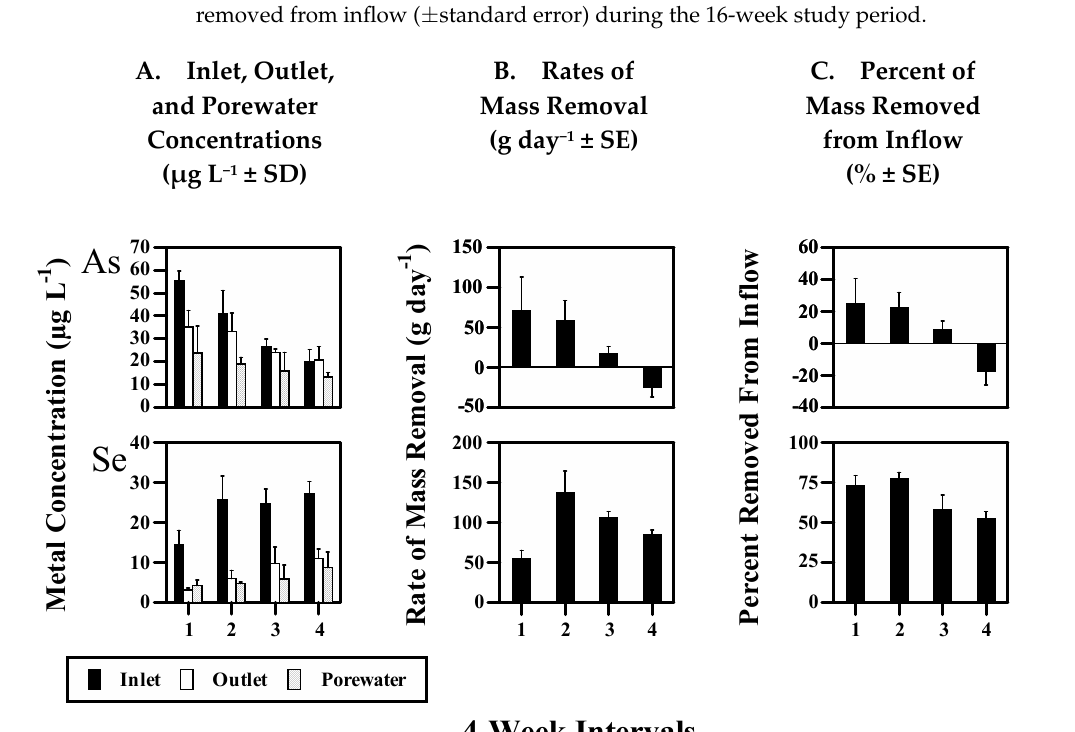
Figure 4. Sink elements: As and Se. Periodic (4 week) mean values for: ( A ) Inlet, Outlet, and Porewater concentrations (µg L − 1 ± standard deviation; n = 4 for inlet and outlet; n = 15–30 for porewater); ( B ) rates of mass removal (g day − 1 ± standard error); and ( C ) percent of mass removed from inflow (± standard error) during the 16 week study period. Porewater concentrations were compared to inlet and outlet concentrations with sim- ilar results. Sink element overall mean porewater concentrations were significantly less than inlet concentrations (Table 2), and were generally less than inlet and outlet concen- trations over time (Figure 4A). In contrast, Zero-flux element mean porewater concentra- tions were not significantly different from inlet and outlet concentrations (Table 2), and were similar to inlet and outlet concentrations over time (Figure 2A), except for Fe. In sharp contrast, Source element mean porewater concentrations were significantly greater than inlet and most outlet concentrations (Table 2), and were generally greater than inlet and outlet concentrations over time (Figure 3A), except for S. The partitioning of dissolved compounds between surface waters and sediments is primarily diffusive, driven by dif- ferences in concentration between the two phases with a strong gradient occurring in sed- iment porewaters. Thus, as the relative differences between porewater and surface (inlet and outlet) water concentrations are similar to the differences based on overall mass fluxes (above), these results indicate that the observed positive and negative overall mass fluxes for Sink and Source elements occurred between surface waters and sediments. Similarly, these results indicate that the overall exchange between surface waters and sediments for Zero-flux elements was limited. 4. Discussion 4.1. Metal Mobilization following Drying/Re-Flooding The concentrations of heavy metals measured here are similar to many found in wastewaters or urban runoff, though Se is higher in dryer climates and for some oil and coal wastes. They are much lower than from most acid metal mines but still much higher